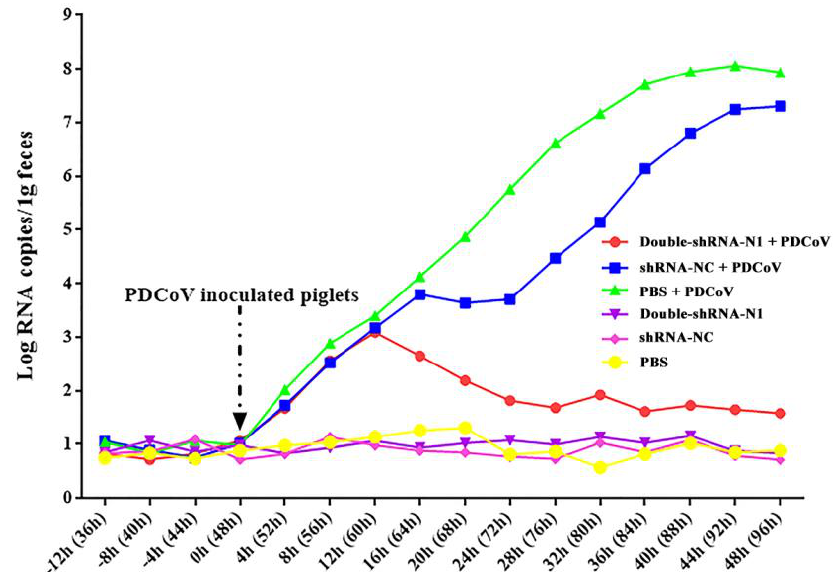
Figure 10. Effects of the double − shRNA − N1 − expressing plasmids treatment in the PDCoV chal- lenge model. The total RNAs from the fecal samples at different time points were extracted, and PDCoV replication kinetics in the piglets were determined by the qRT-PCR method. The PDCoV quantity was calculated and expressed as viral copies per 0.1 g feces, based on the standard curve.